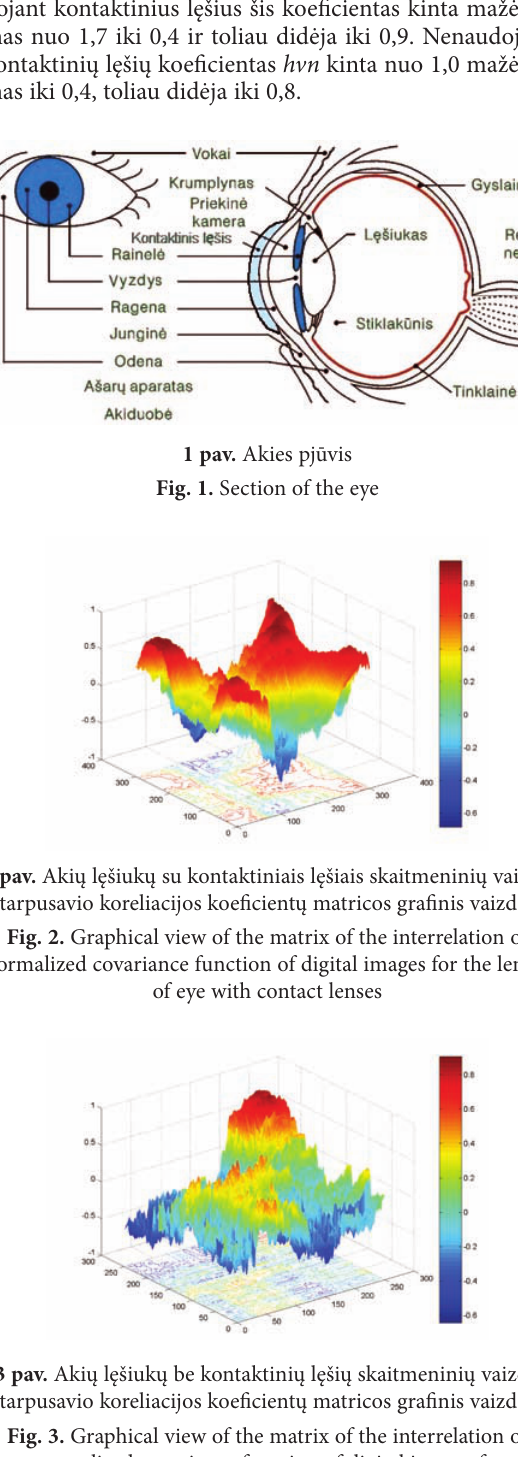
Fig. 3. Graphical view of the matrix of the interrelation of normalized covariance function of digital images for the lenses of the eye without contact